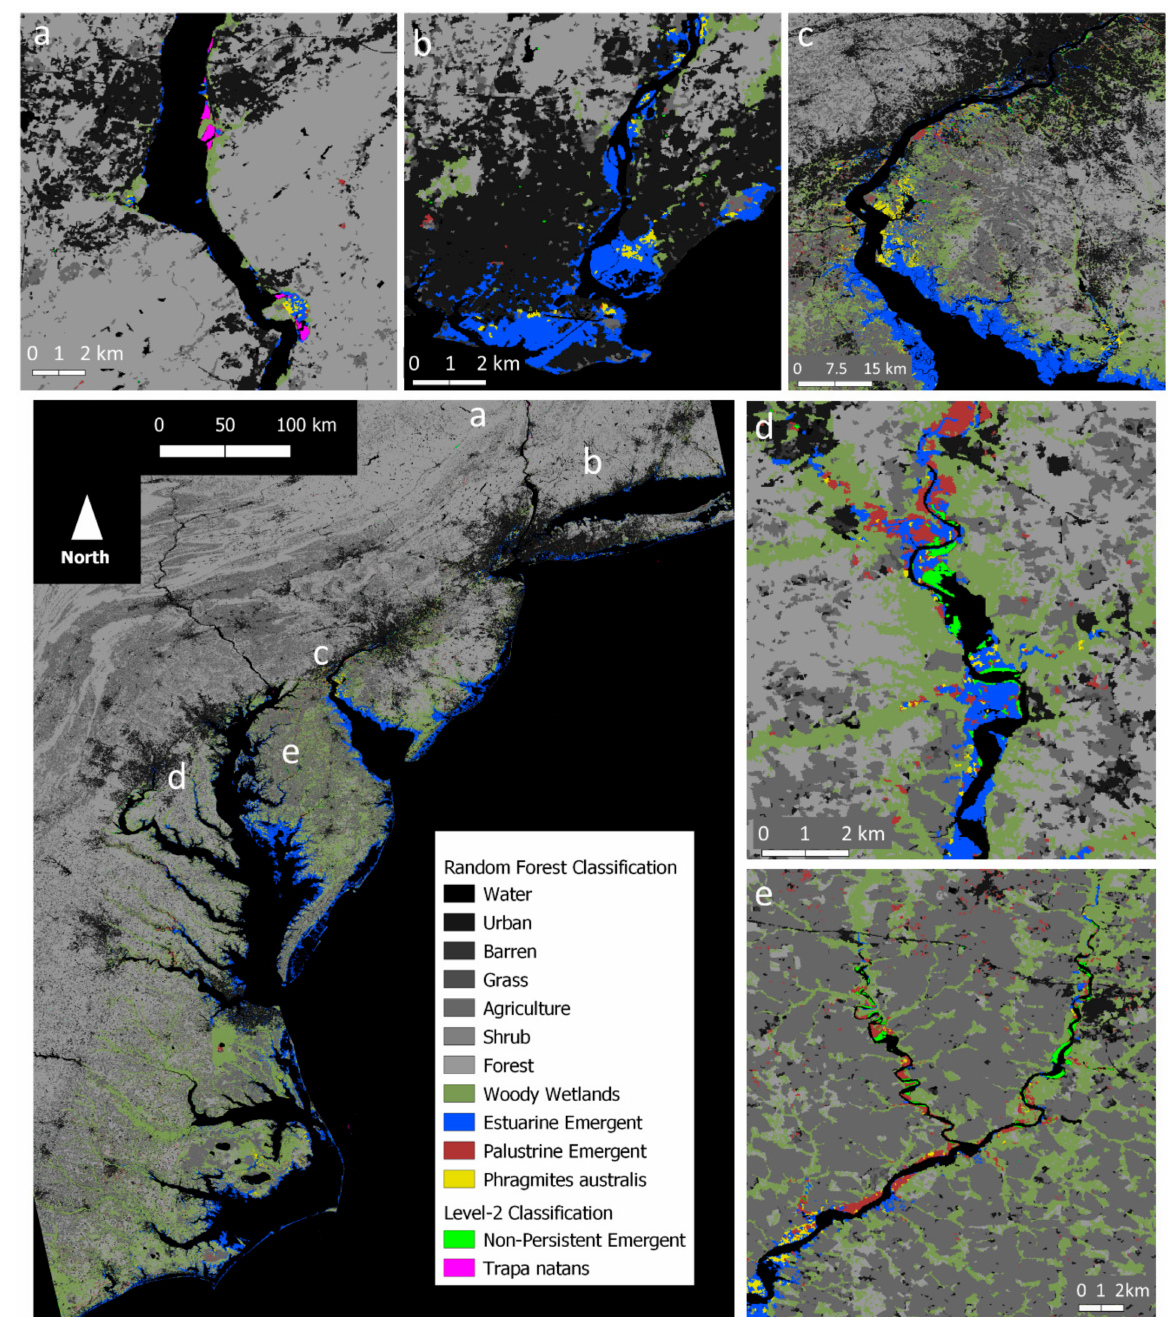
Figure 13. Maps of Mid-Atlantic level-2 classification, which use a decision tree classifier to modify the level-1 classification. Level-1 random forest classification wetland colors have been muted to highlight non-persistent emergent wetlands in bright green and T. natans in magenta. Panels ( a – e ) correspond to the Hudson River, Housatonic River/Wheeler Marsh, Delaware River Patuxent River, and Choptank River, respectively. Please note that the extents of panels ( d , e ) are zoomed relative to their extents in Figure